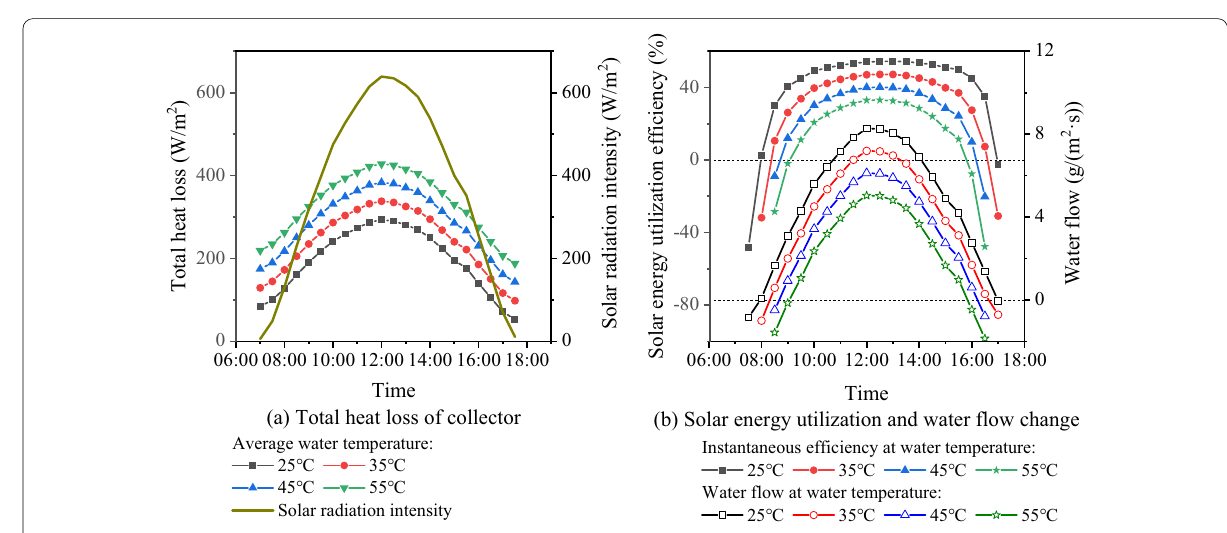
Fig. 5 The collector is connected in parallel with the auxiliary heat